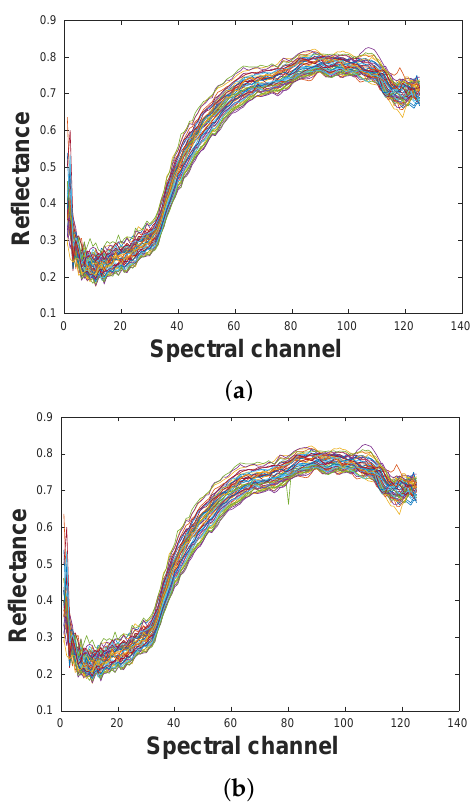
Figure 1. ( a ) The original undistorted curve families for the artificial example. ( b ) An example where a small artificial change has been introduced to the data set in Figure 1a at spectral channel